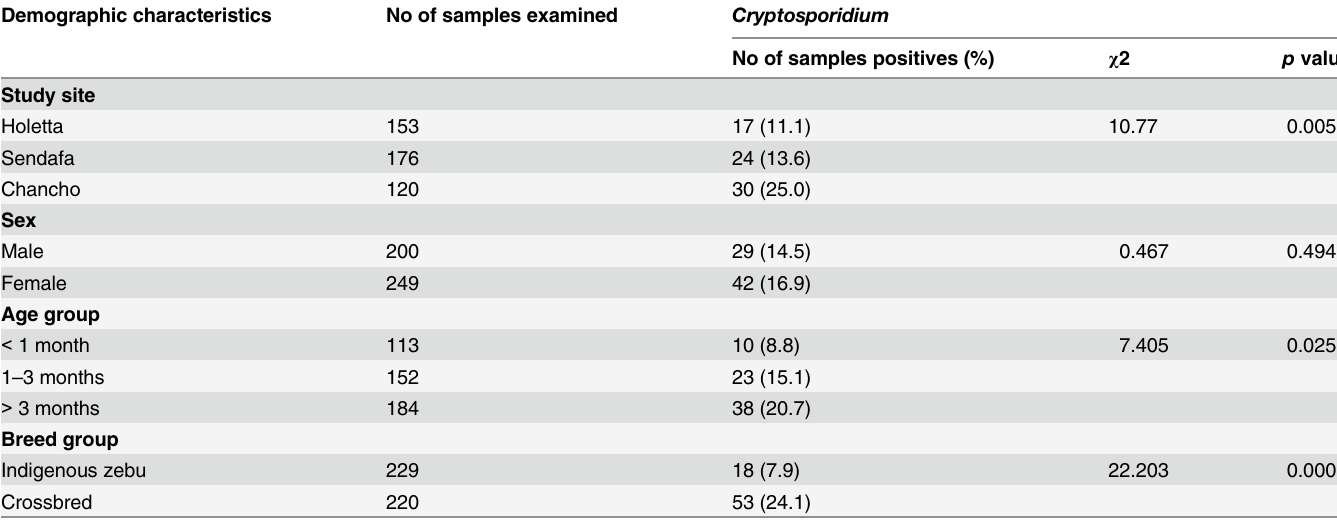
Key: p values compare the prevalence among study sites, sex, age and breed groups Asterisks ( * ) Represent statistically signi fi cant